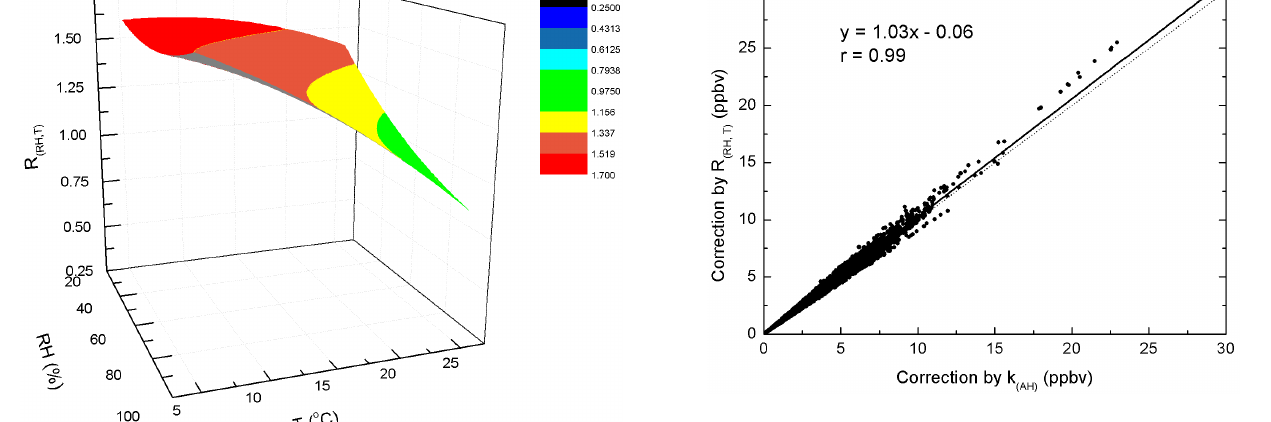
Figure 6. Linear regression of two correction methods for HCHO concentrations during the field study at MK in Hong